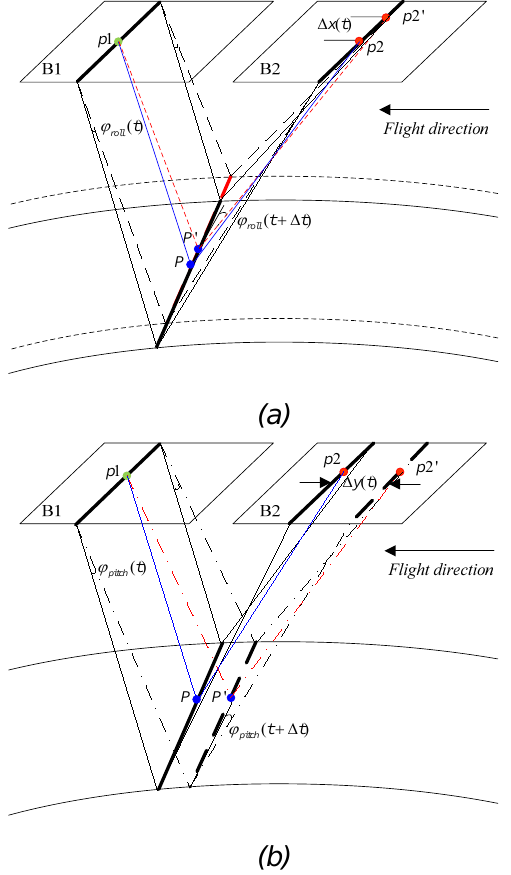
Figure 3. Band-to-band registration error caused by rolling fluctuation (a) and pitching fluctuation (b)